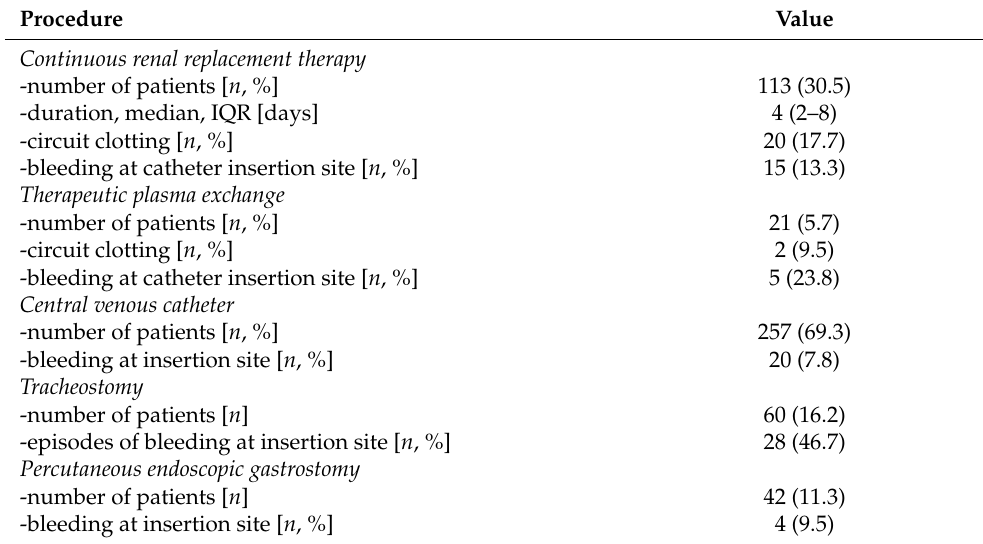
Table 4. Invasive procedures and iatrogenic blood